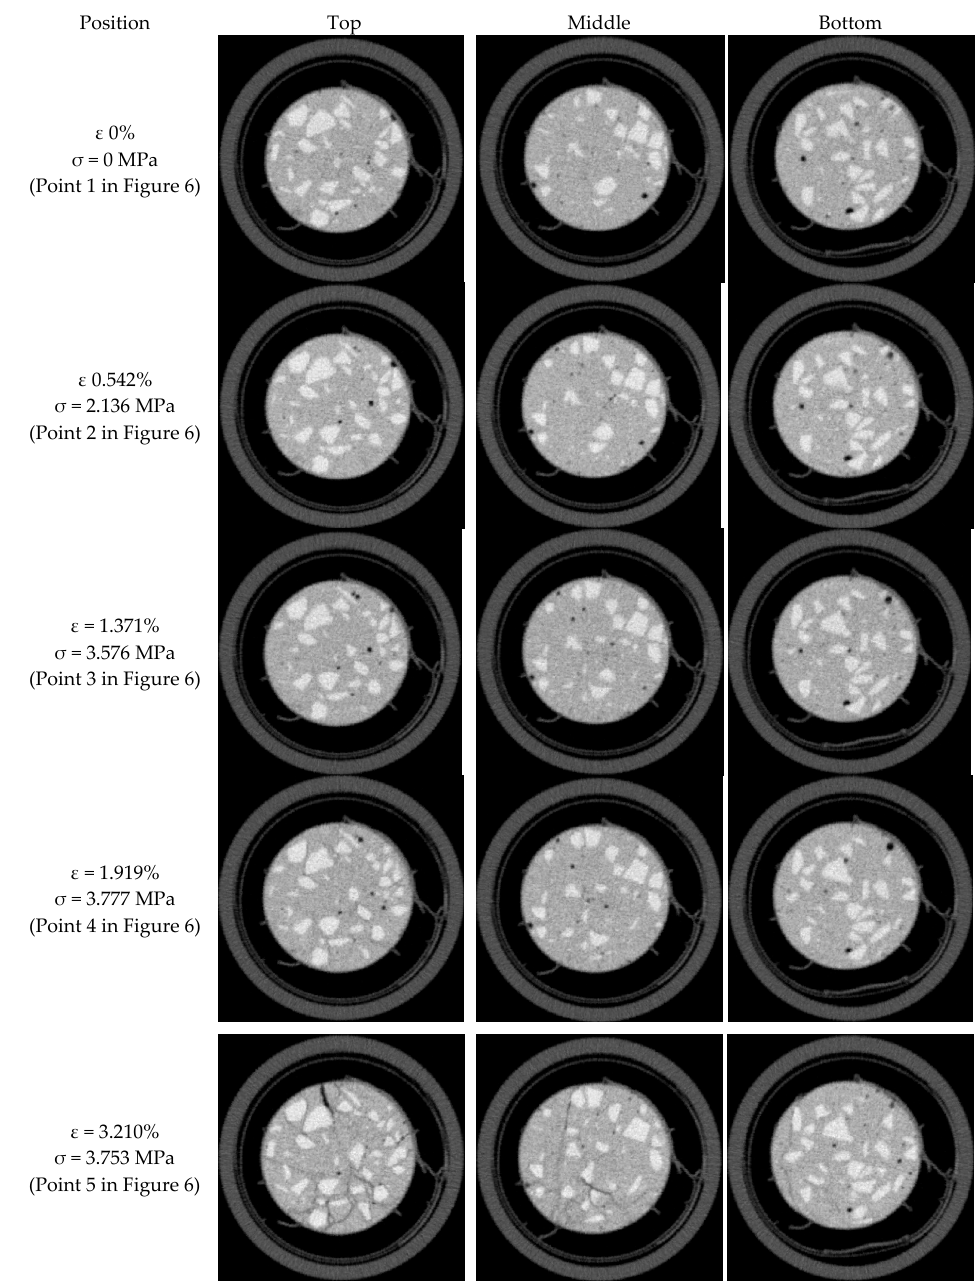
Figure 9. The reconstructed CT images of the CWRTB sample at the top, middle, and bottom positions at five loading stages.